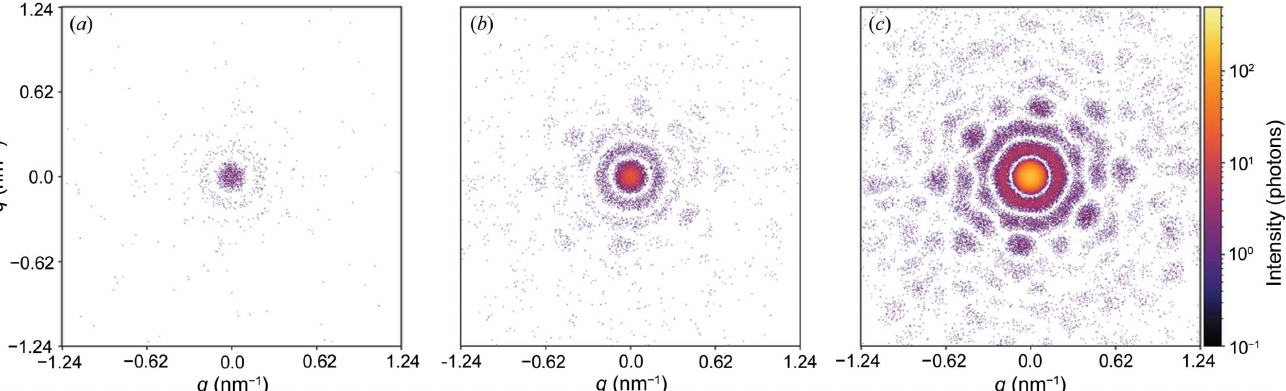
Figure 4 Diffraction patterns from a single TBEV in a random orientation. Signal intensities: ( a ) 10 10 photons, ( b ) 10 11 photons and ( c ) 10 12 photons at the focus. The simulated sample-to-detector distance is 2.5 m. Detector parameters are the same as in Fig. 3.